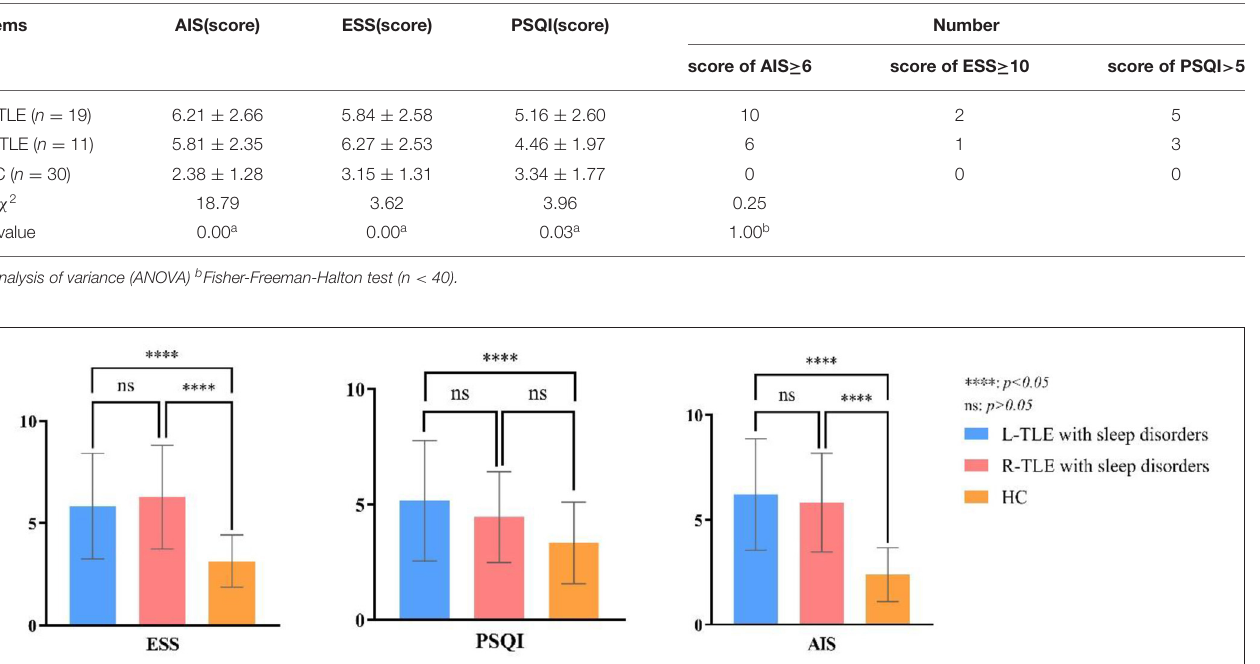
FIGURE 3 | Post-hoc multiple comparison in sleep scores of TLE with sleep disorders and the healthy controls.